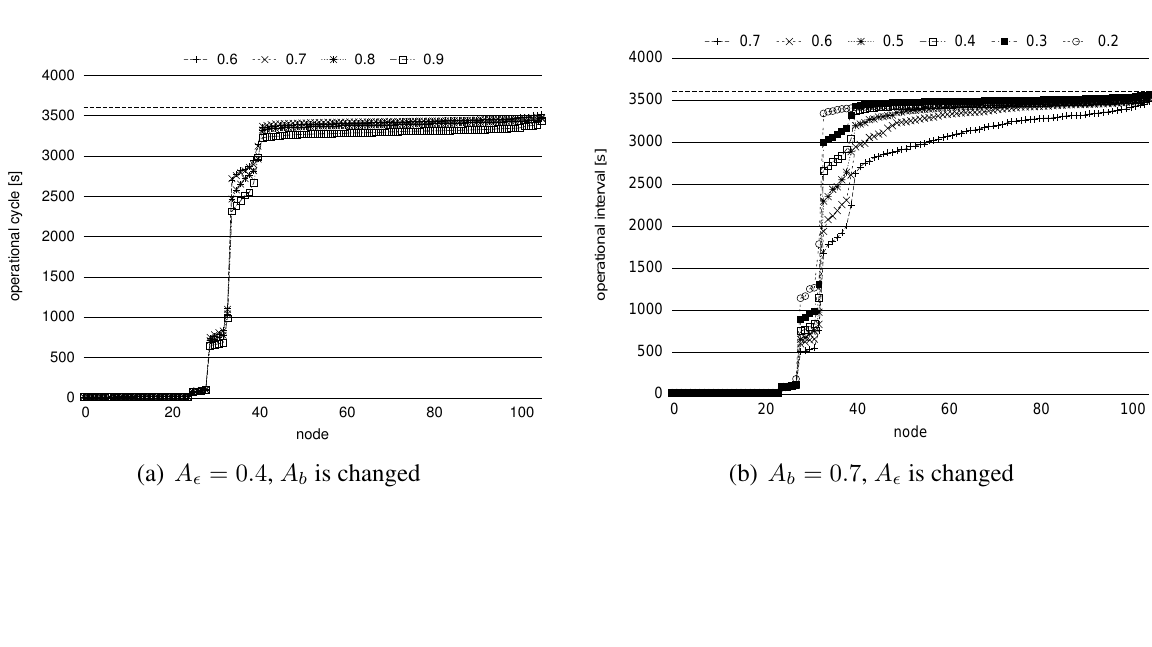
Figure 15. Operational interval ( A